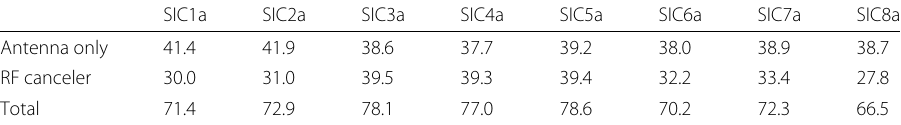
Table 3 Isolation provided by the modified antenna and the RF canceler and the total isolation in dB SIC1a SIC2a SIC3a